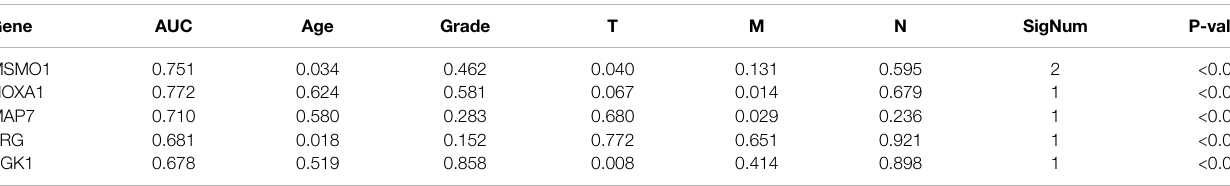
TABLE 1 | Genes associated with clinical relevance and independent prognosis in TCGA